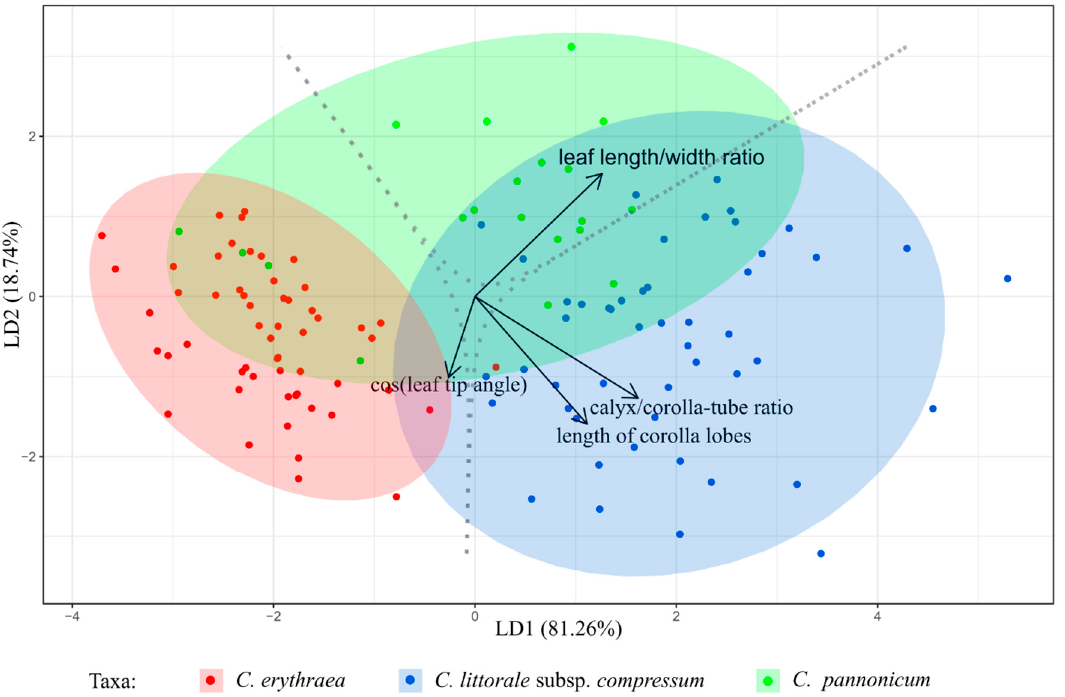
Figure 2. Visualization of LDA of three Centaurium taxa (groups were defined as: C. erythraea , C. littorale subsp. compressum and C. pannonicum ) based on the following characters: length / width ratio of floral stalk leaves, calyx / corolla-tube ratio, length of corolla lobes, and cosine of the leaf tip angle. For graph construction, the LDA model fitted on all the data was used. Model decision bounds are indicated by the dashed lines.